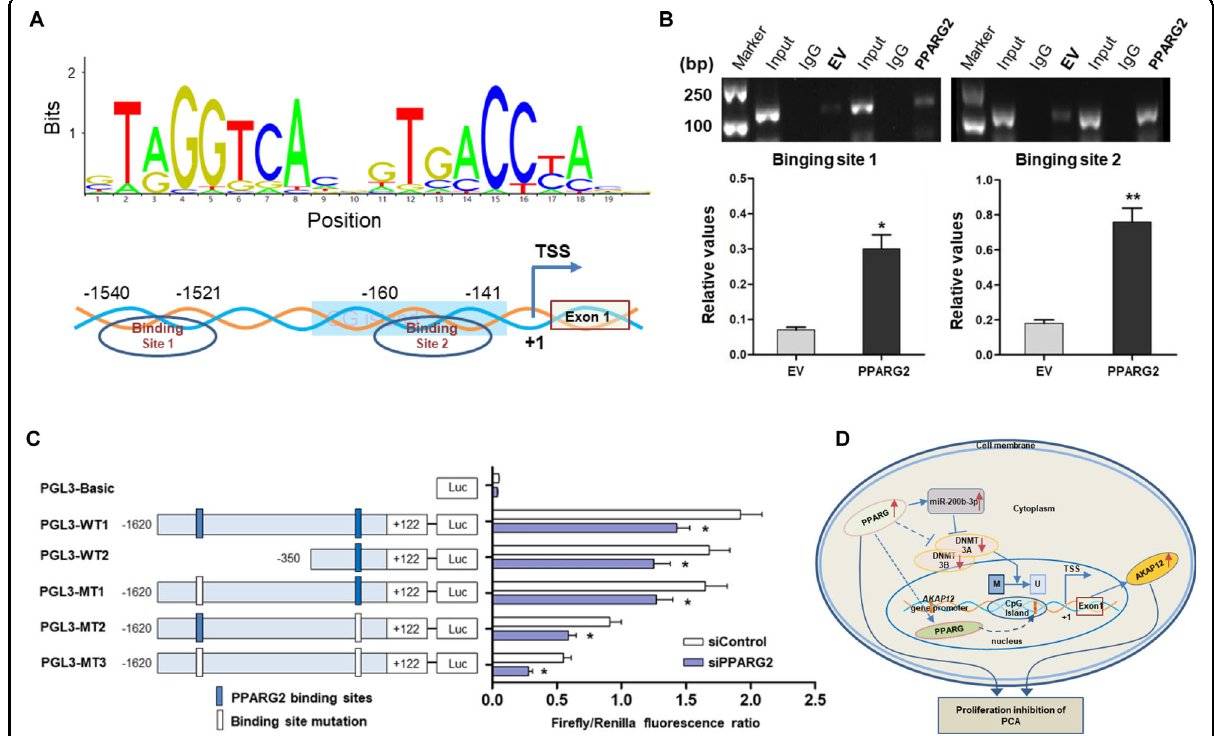
Fig. 8 Enhanced binding of PPARG2 to AKAP12 promoter region due to DNA demethylation when PPARG2 is upregulated. A Scheme for binding sequence and sites of PPARG2 binding to the transcription factor-binding site near the AKAP12 gene promoter region. TSS, transcription start site. B ChIP assay revealing the direct binding of PPARG2 to the AKAP12 gene promoter in PC3 cells between the EV and PPARG2 group. The enriched DNA fragments within the AKAP12 gene promoter using IgG and an anti-PPARG2 antibody were ampli fi ed by PCR. Total input was used as a positive control. * P < 0.05, ** P < 0.01 vs. EV group. C Serially truncated and mutated AKAP12 gene promoter constructs were co-transfected with siPPARG2 or siControl into PC3 cells, and the relative luciferase activities were determined. * P < 0.05 vs. siControl group. D Proposed graphic model for PPARG2- AKAP12 axis-mediated epigenetic regulation mechanism of proliferation, migration, and invasion in PCA